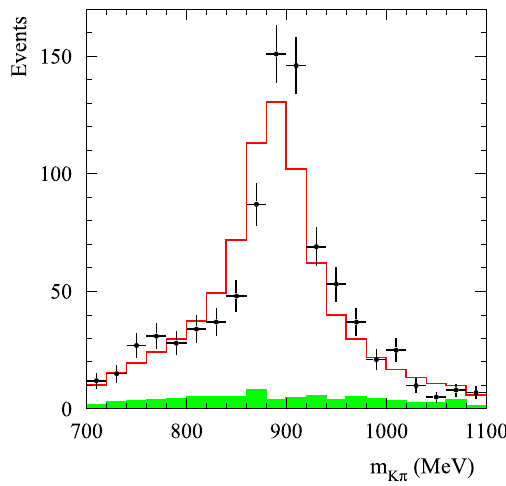
Fig. 7 The K π 0 invariant mass spectrum for data events from the √ s < 1 . 72 GeV (points with error bars). The solid energy range 1 . 5 < histogram is the sum of the simulated e + e − → K + K − π 0 distribution and background. The hatched histogram represents the background